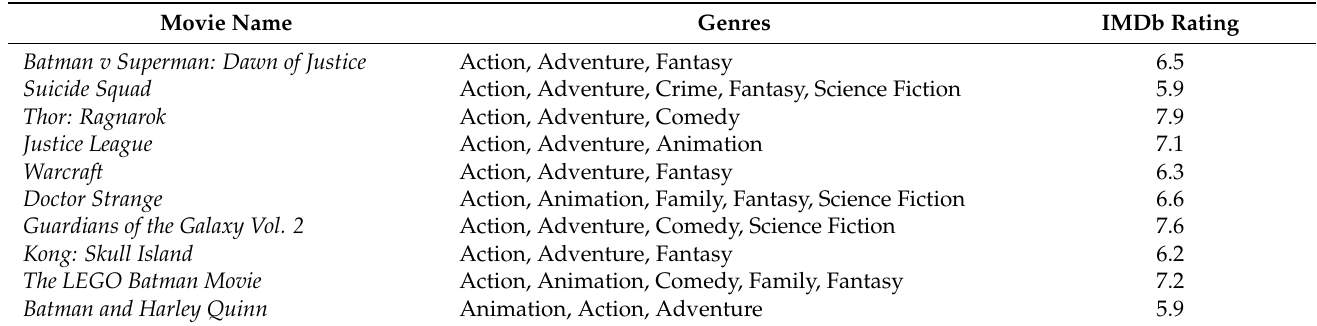
Table 19. Recommended movies for the animated movie Wonder Woman according to the hybrid recommendation system proposed in